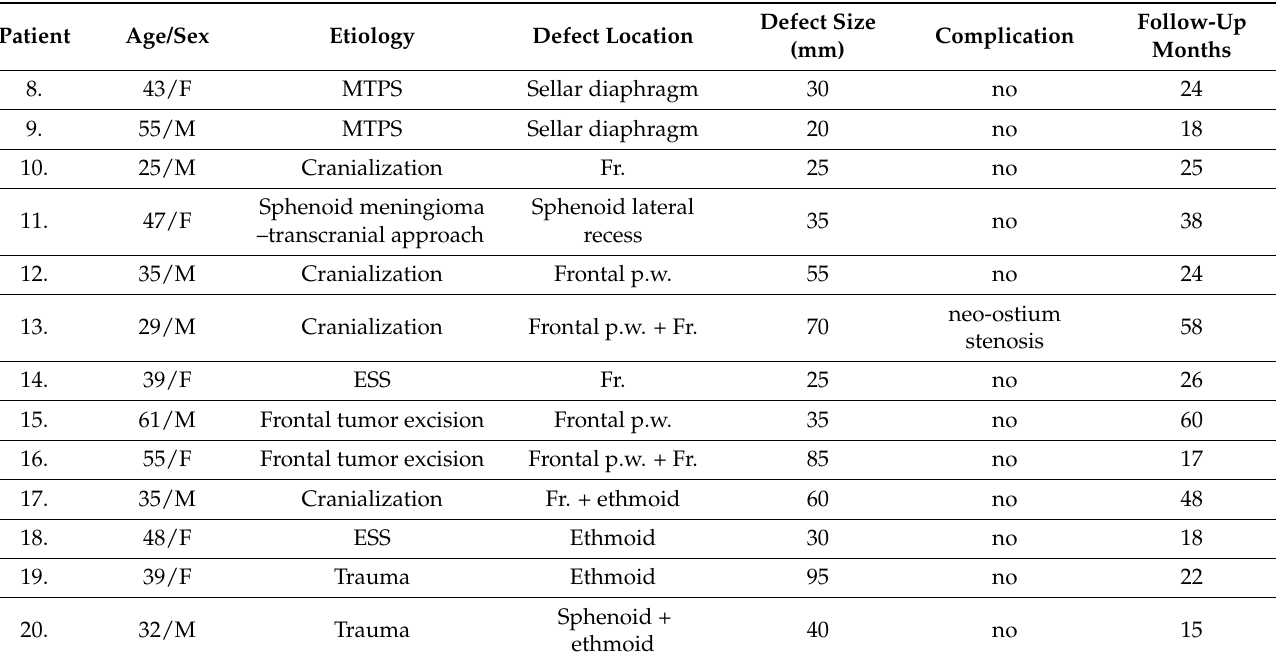
Figure 5. Cranial CT, axial plane, of a patient (no. 6) with tension pneumocephalus and visible Mt Fuji sign.